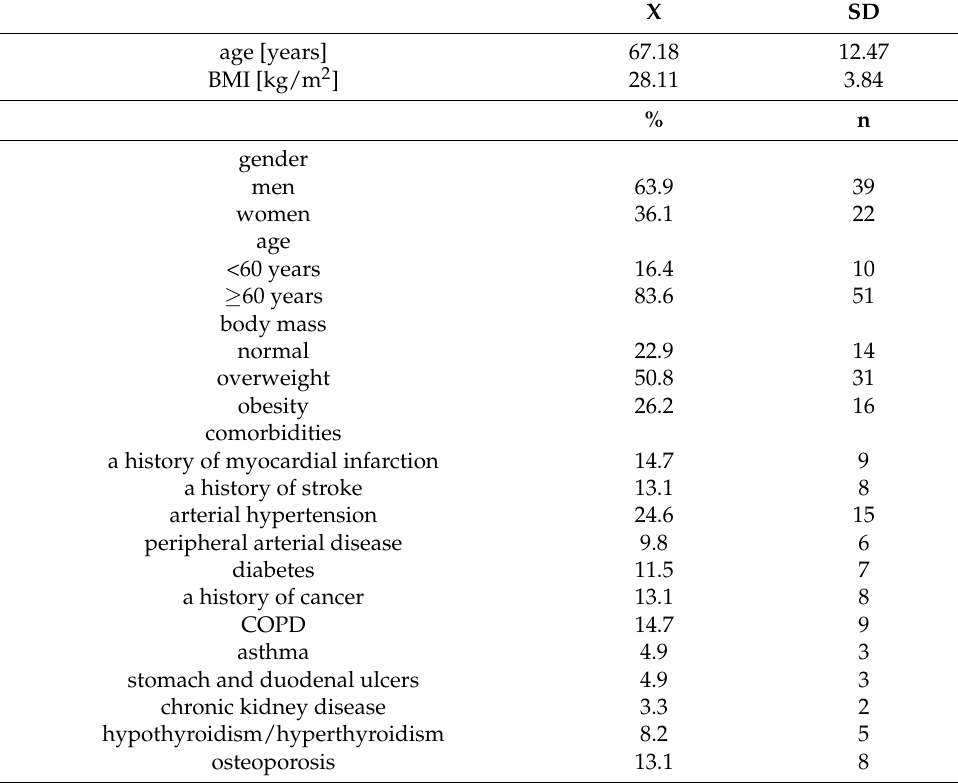
Table 1. General characteristics of the study